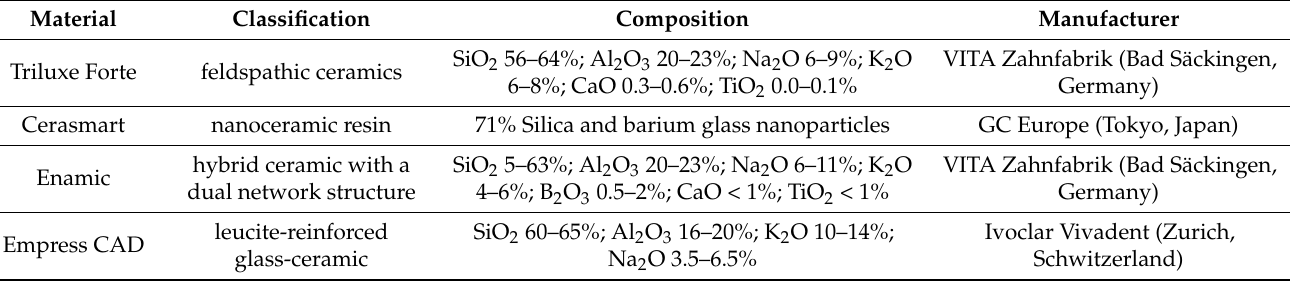
Table 1. The composition, manufacturer, and classification of the tested monolithic